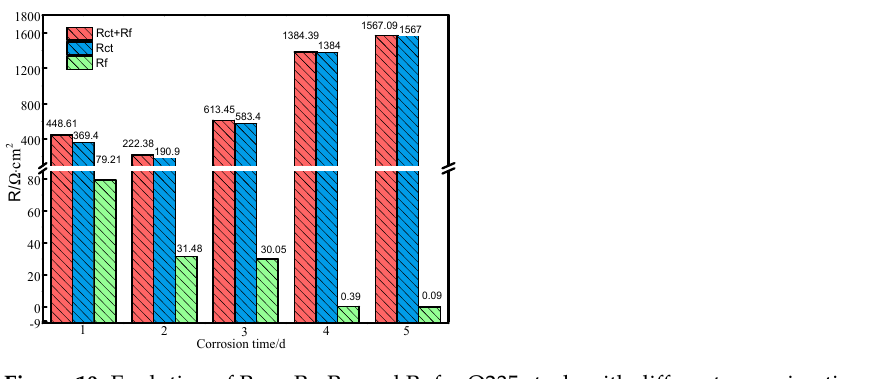
Figure 10. Evolution of R ct + R f , R ct and R f for Q235 steels with different corrosion times.